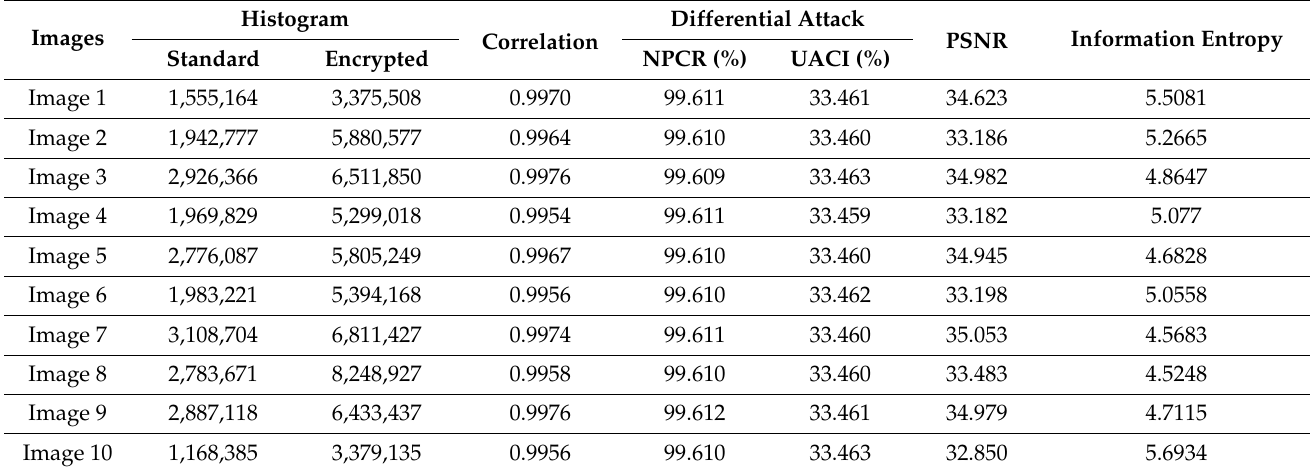
Table 1. Statistical metrics for CT modality without noise.